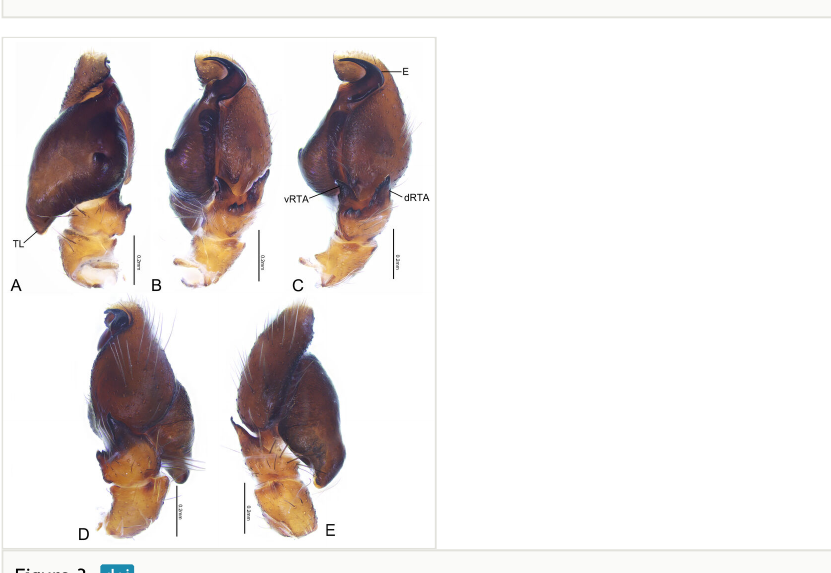
Figure 3. Tasa koreanus (Weso ł owska, 1981): A male left palp, ventral view; B same, retrolateral- ventral view; C same, retrolateral view; D same, dorsal view; E same, prolateral view. Abbreviations: E—embolus; dRTA—dorsal branch of retrolateral tibial apophysis; TL—tegular lobe; vRTA—ventral branch of retrolateral tibial